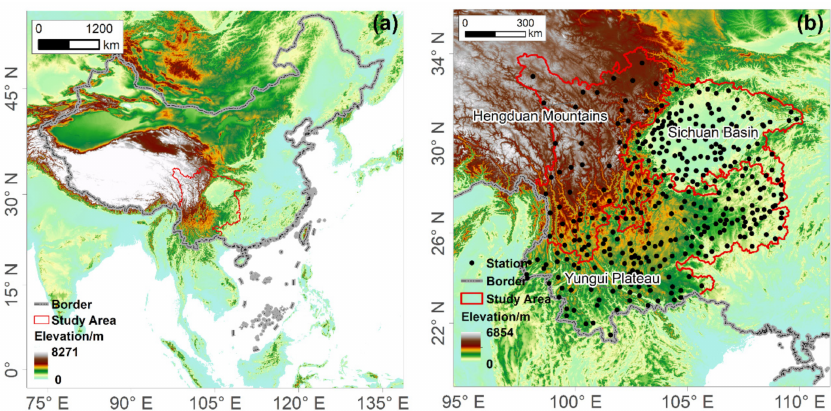
Figure 1. Distribution of meteorological stations, DEM and subarea division in Southwest